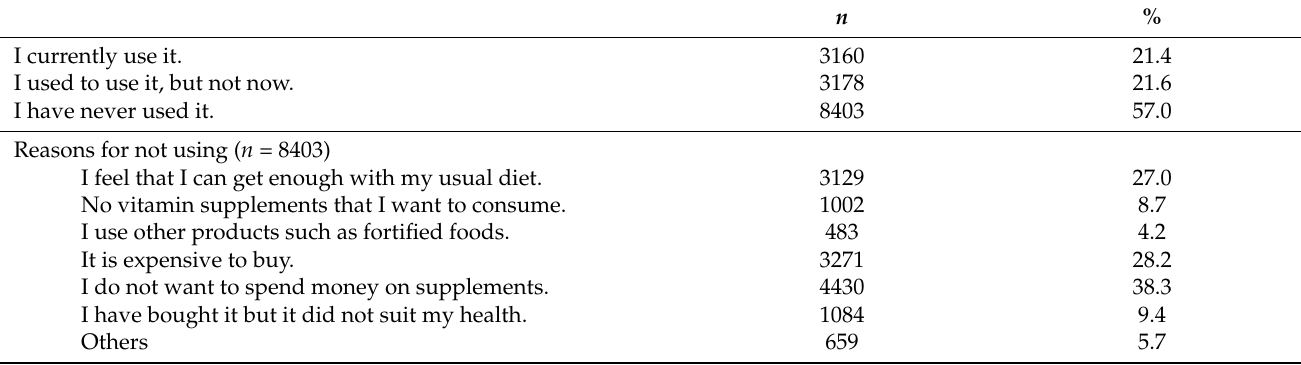
Table 4. The prevalence of vitamin supplement usage and reasons for non-usage.